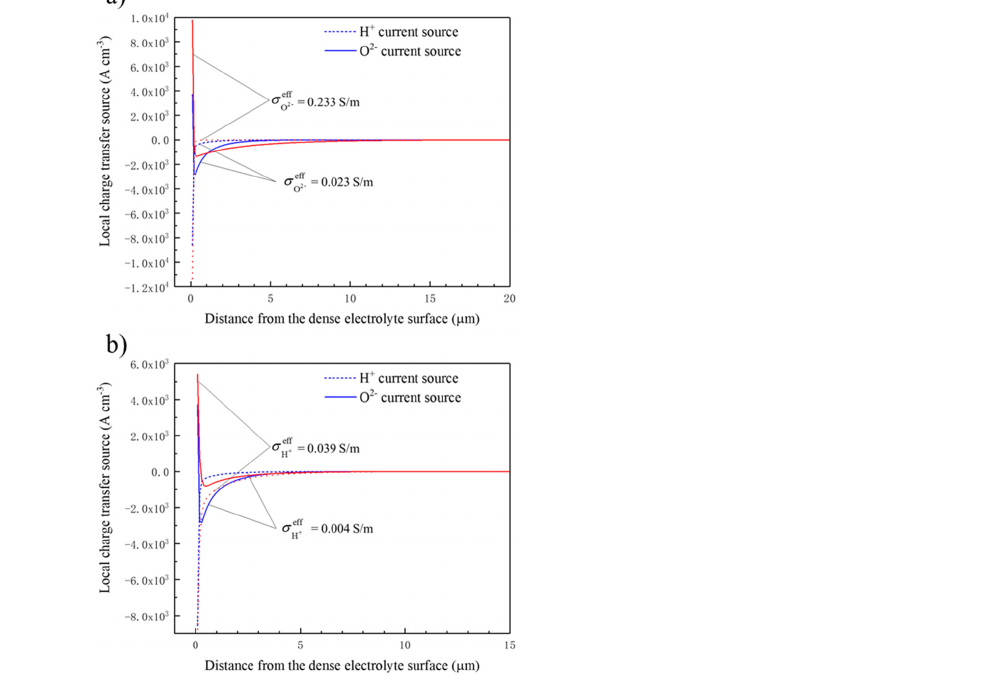
Figure 9. The dependences of the distributions of the local oxygen ions and protons generation rates on different ionic conductivities. ( a ) Different oxygen ionic conductivity; ( b ) different protonic con ‐ ductivity.